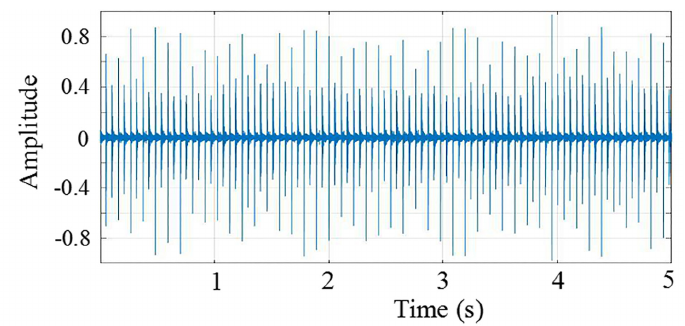
Figure 3. When the discharge simulation module controls the SIL to generate a discharge, it makes an obvious sound. A significant increase inordinate data means a discharge generation of the